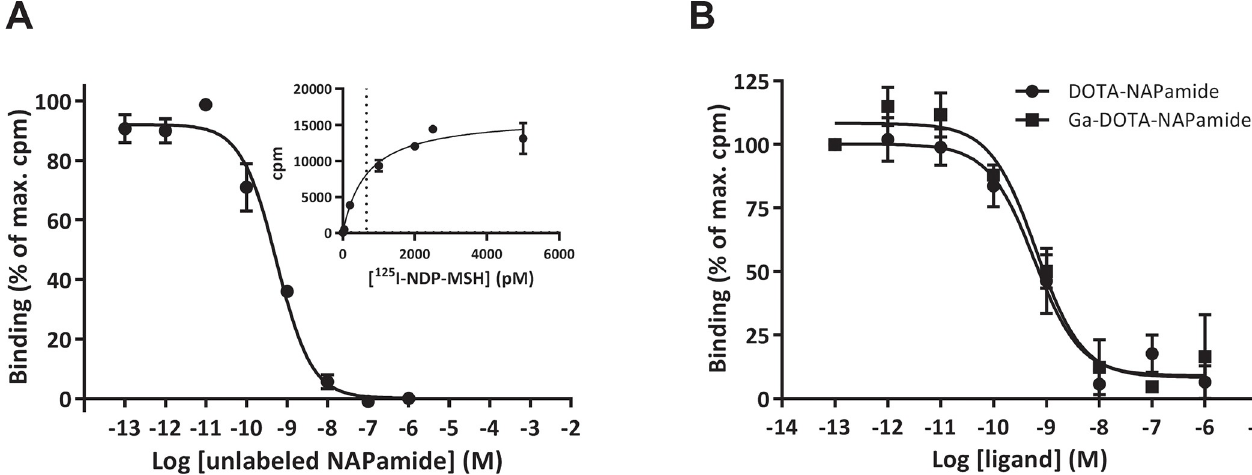
Fig 1. DOTA-NAPamide and Ga-DOTA-NAPamide are high affinity ligands for the melanocortin 1 receptor (MC1R): 125 I-NDP-MSH ligand displacement and saturation assays performed with whole B16/F1 cells. A Various concentrations of NAPamide were used to displace 125 I-NDP-MSH. The inset shows a saturation experiment to determine the dissociation constant. B 125 I-NDP-MSH ligand displacement assay to assess the impact of gallium chelation on DOTA-NAPamide. Curve fits were performed in GraphPad Prism by applying a one-site binding equation. (n = 3; mean +/- SEM).